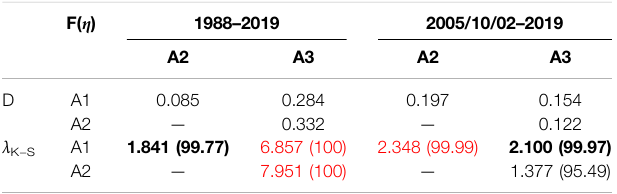
TABLE 7 | The Kolmogorov-Smirnov two-sample statistic λ K − S applied to distribution functions of USLE control parameter η . F( η